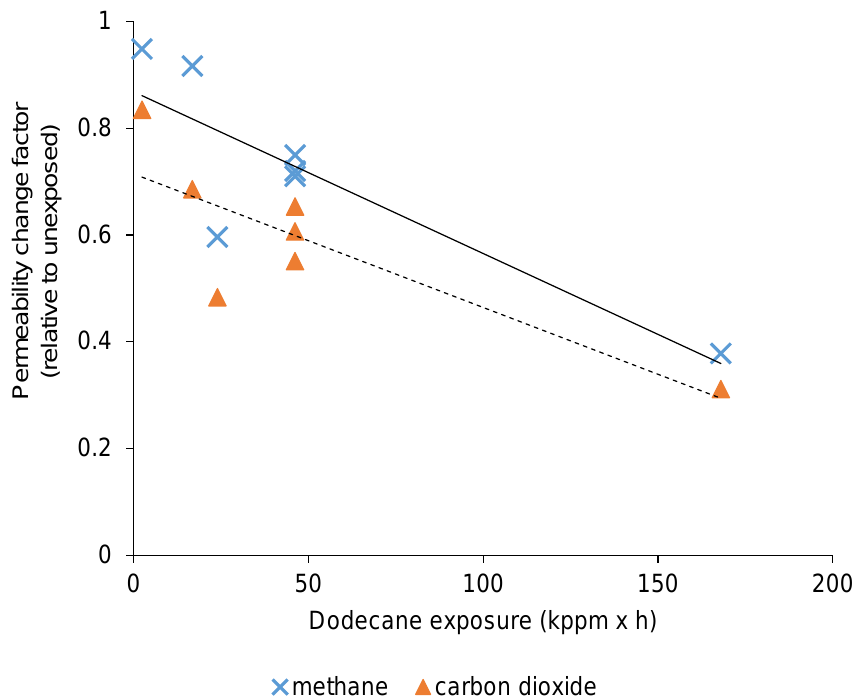
Figure 5. Alteration of gas permeabilities after exposures to dodecane (the dotted trend line belongs to CO 2 ).